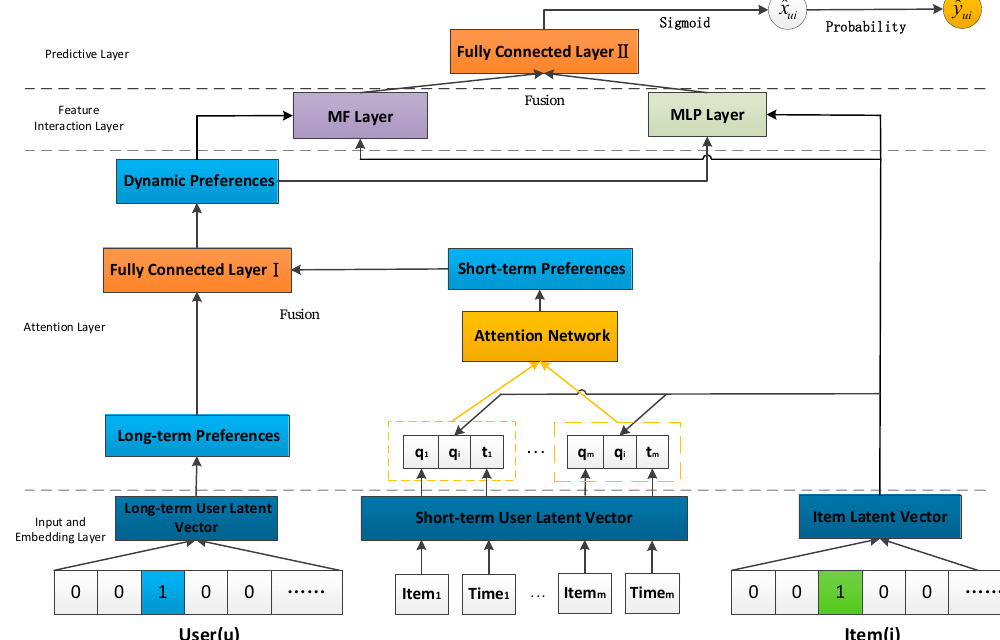
Figure 1. The overall architecture of the A-DNR framework.